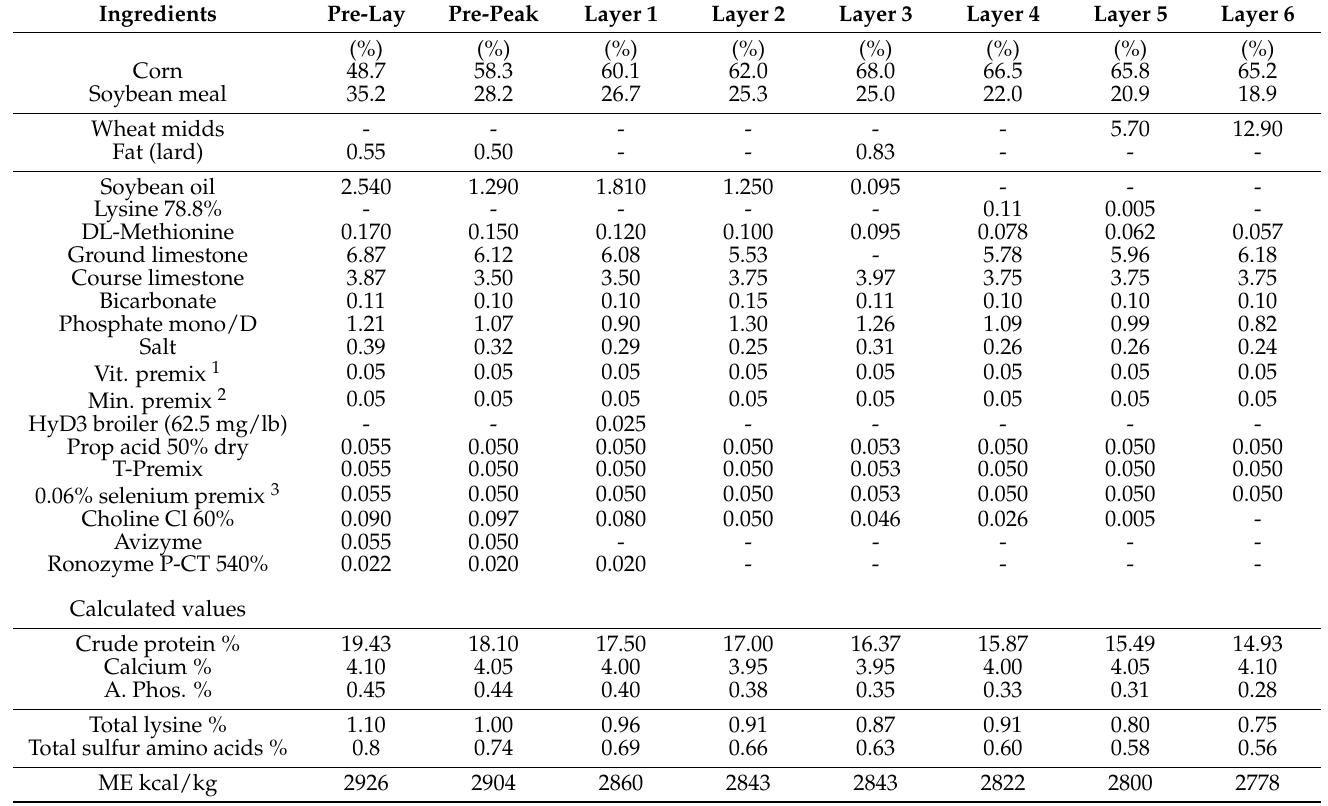
Table 2. Ingredient composition and calculated nutrient analysis of diets fed to all hens according to the feeding program described in Table